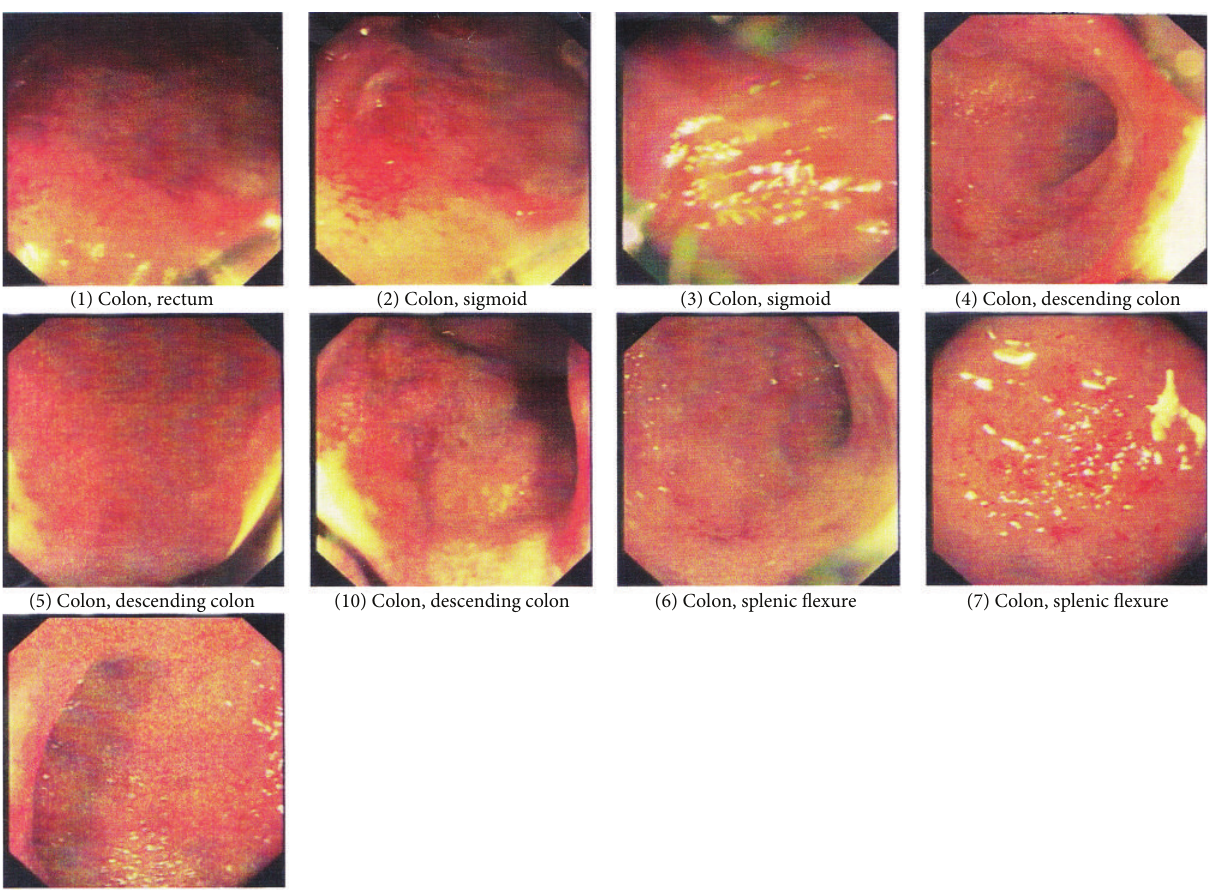
Figure 1: Sample colonoscopic findings at